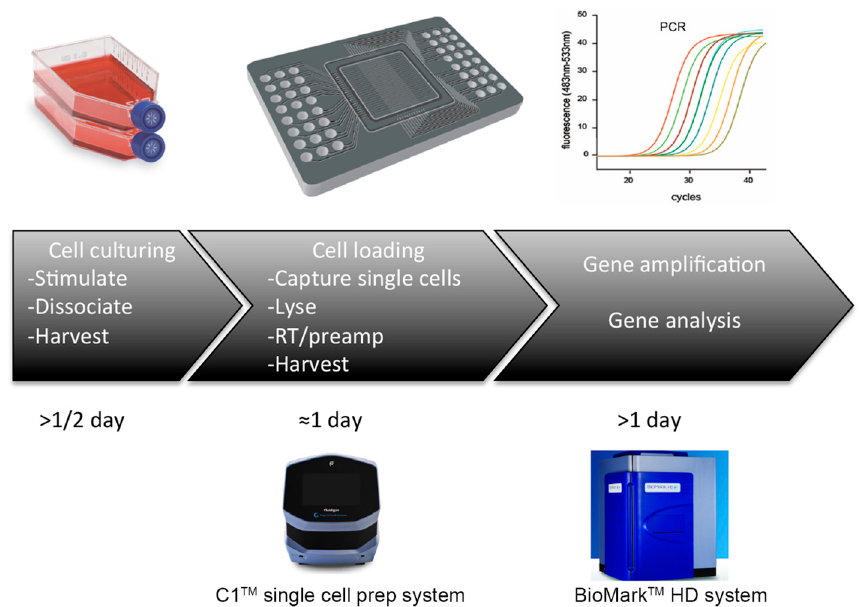
Figure 2. Microfluidics. Lab-on-a-chip technology allows for high-throughput screening in a microenvironment using small volume chambers to conduct different experiments. ( Upper ) Similar to FACS, the cells need to be dissociated prior to the experiments; ( Middle ) the cells are typically placed in a chamber and, depending on the technology, the cells may be separated into different chambers containing only one cell; ( Lower ) the technology currently used by Fluidigm are single-phase microfluidic systems using multilayer soft lithography to make on and off valves to compartmentalize the cells. Another promising technology is the droplet-based microfluidics to handle small volumes of fluids. ( Right ) following single-cell isolation, lysis and cDNA synthesis the samples are subjected for gene analysis. A typical qPCR profile is shown with different colors representing the amplification curve of target gene(s).